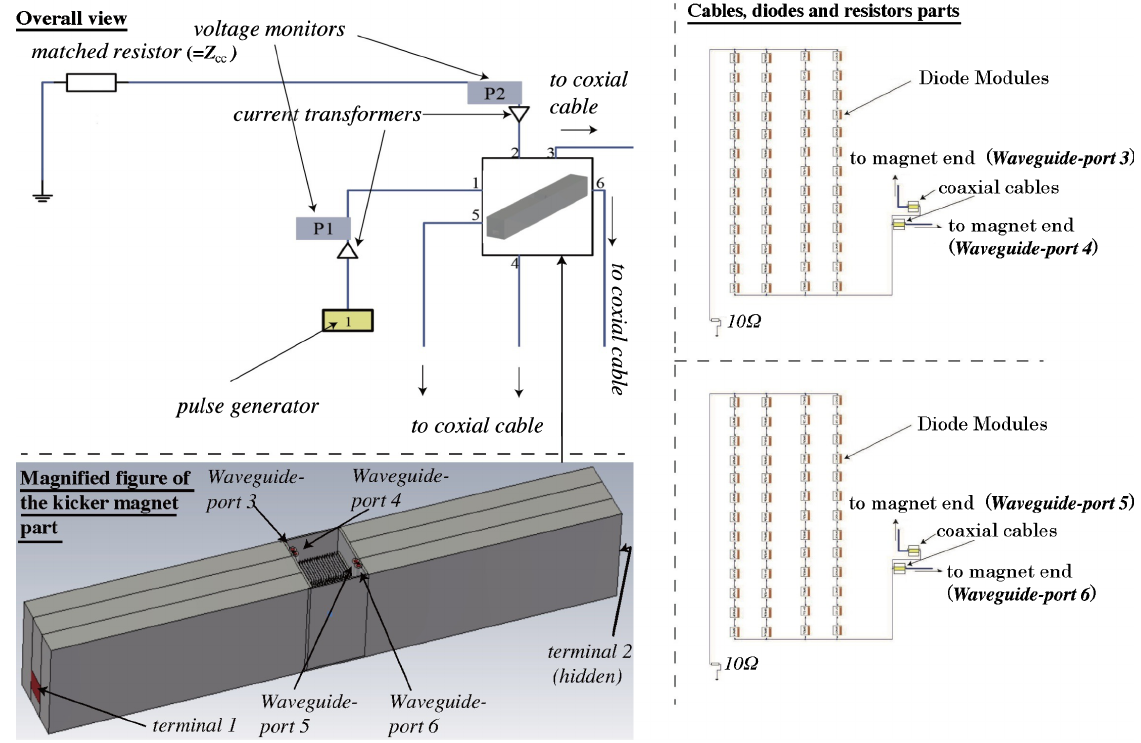
FIG. 11. Overall view of simulation setup for single wire measurements (upper left), the magnified figure of the kicker magnet part (lower left) and the terminal condition of all cables